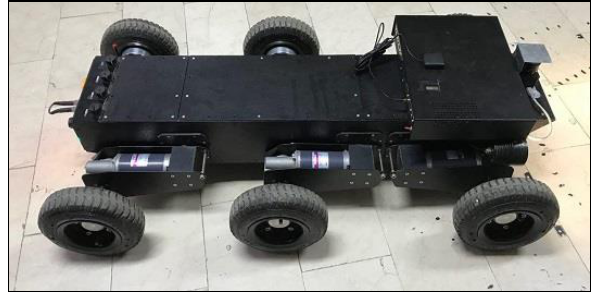
Figure 1. Six-wheeled surveying robot